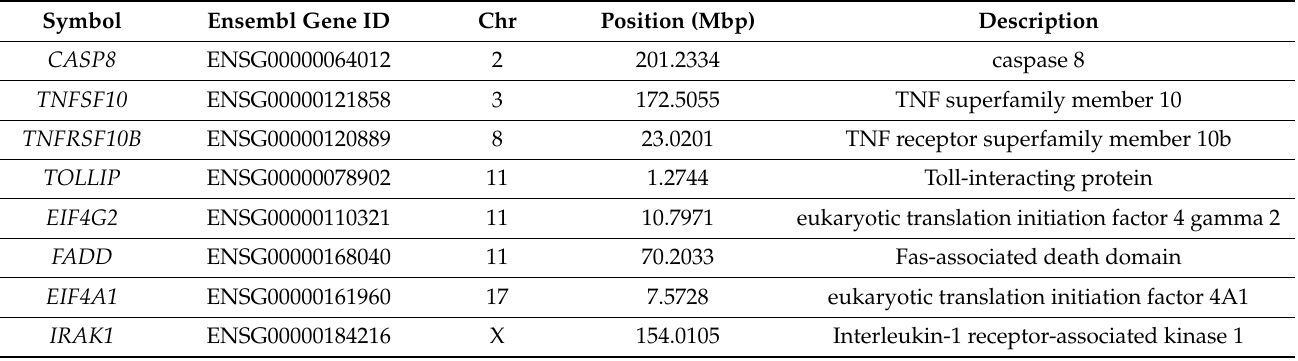
Table 3. Validated miRNA-146a and miRNA-126 target genes included in enrichment analysis.